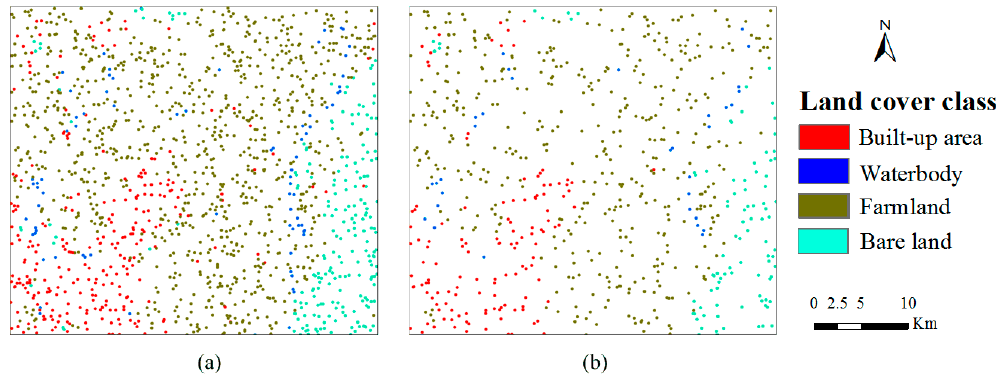
Figure 2. Expert-interpreted land use/cover sample data for the study area in Yinchuan: ( a ) a subset of 1428 sample data for MCRF co-simulation (0.087% of the total image pixels); and ( b ) a subset of 518 sample data for validation.